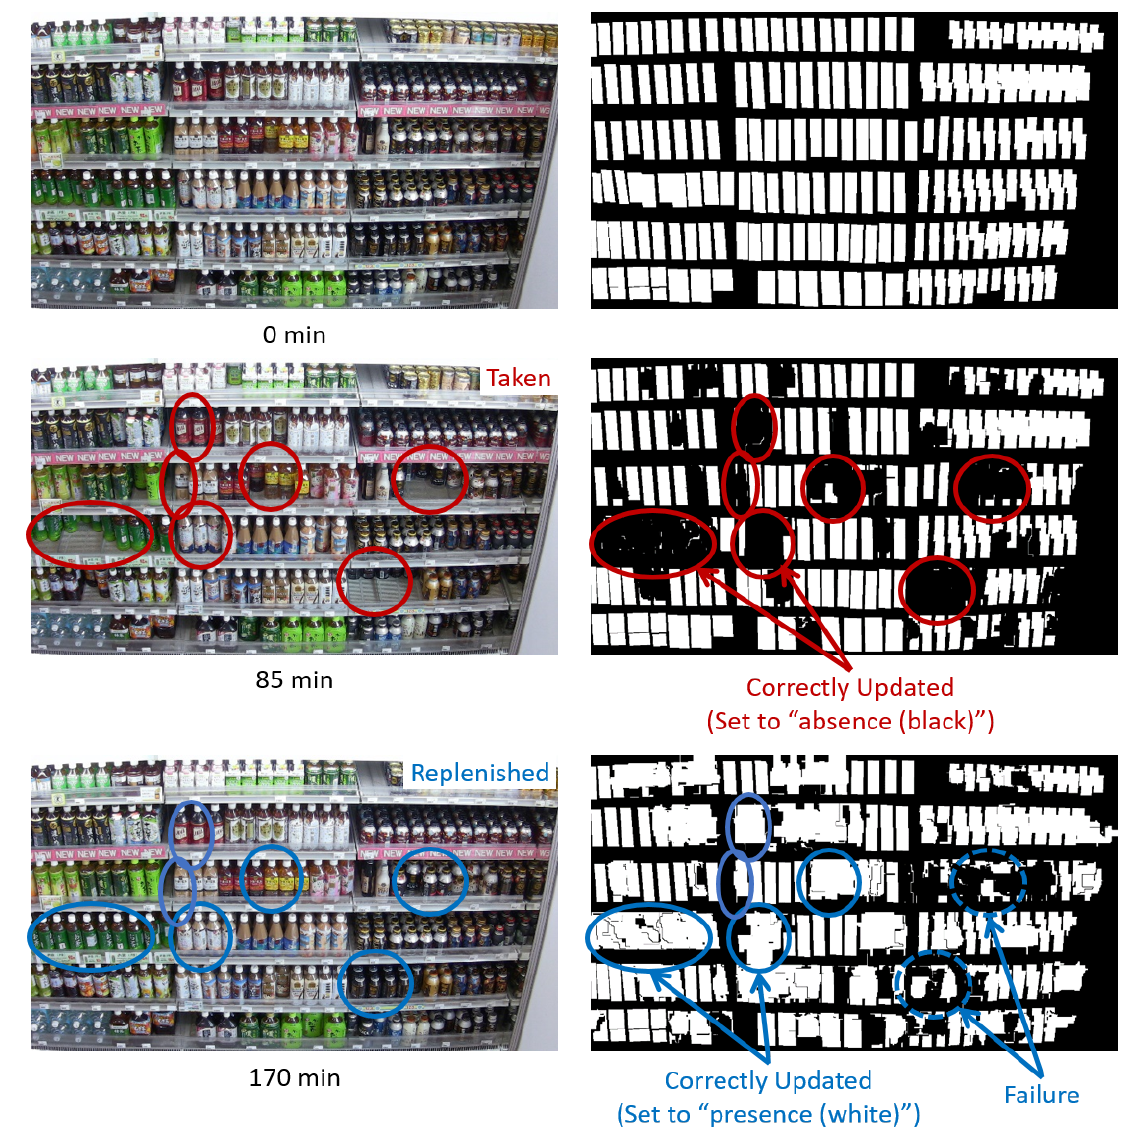
Figure 18. Some results for updated shelf condition in video